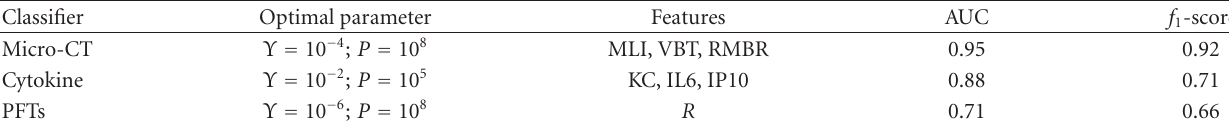
Table 6: Optimal estimated parameters, best features and corresponding area under the ROC curve (AUC), and f 1 -score for each classifier (trained on micro-CT density-based descriptors, RNA cytokine expression data, and single compartment model parameters from pulmonary function tests (PFTs)) are shown.